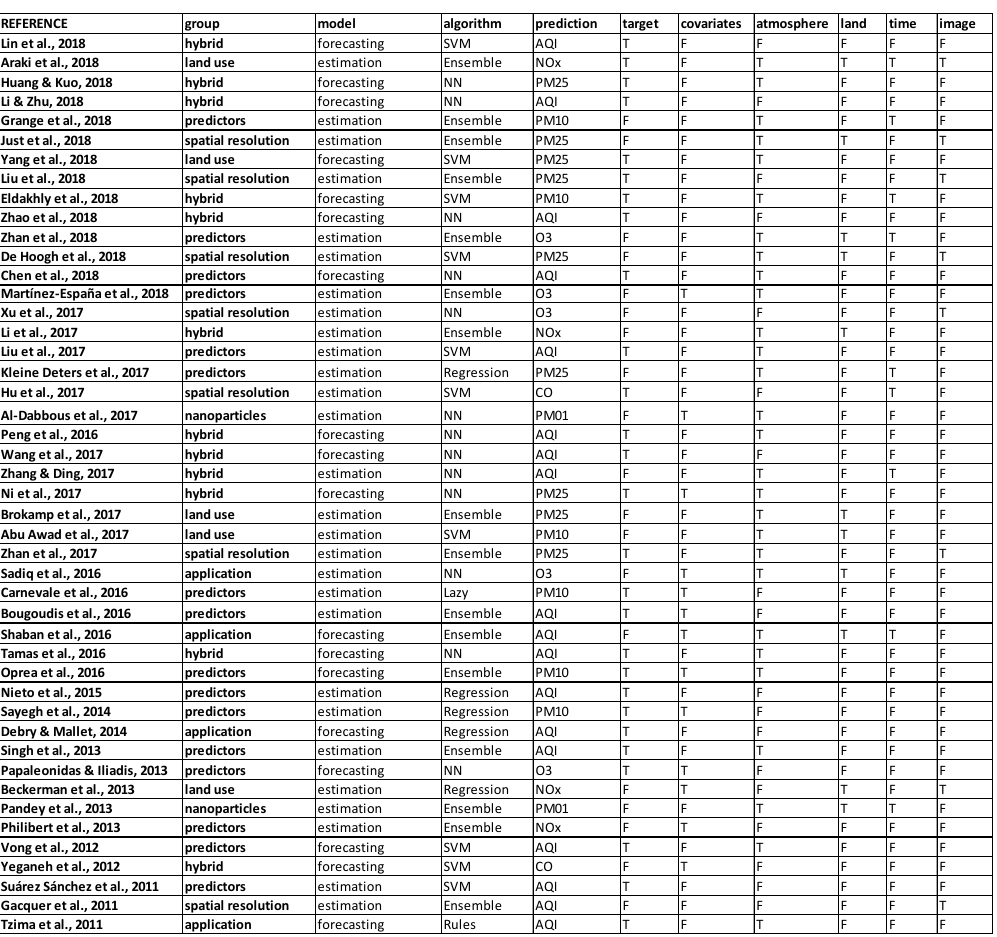
Figure A1. Source table used to perform the Multiple Correspondence Analysis